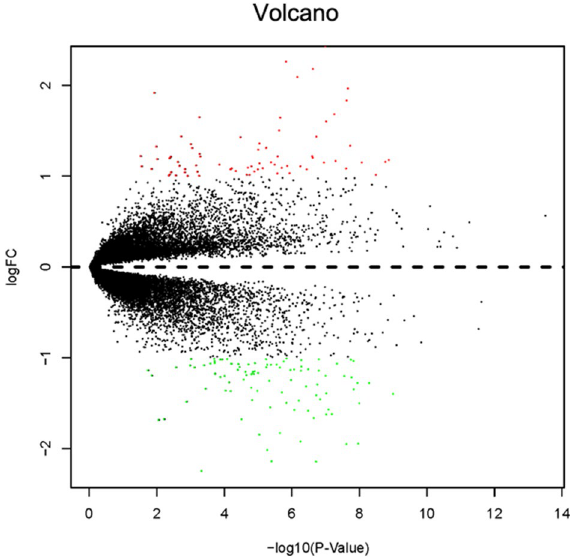
Figure 2. Volcano plot of mRNA expression in the training set (n = 226, GSE31210). The red points in the volcano plot represents the statistically significant highly expressed mRNAs, and the green points represent mRNAs with significantly low expression.